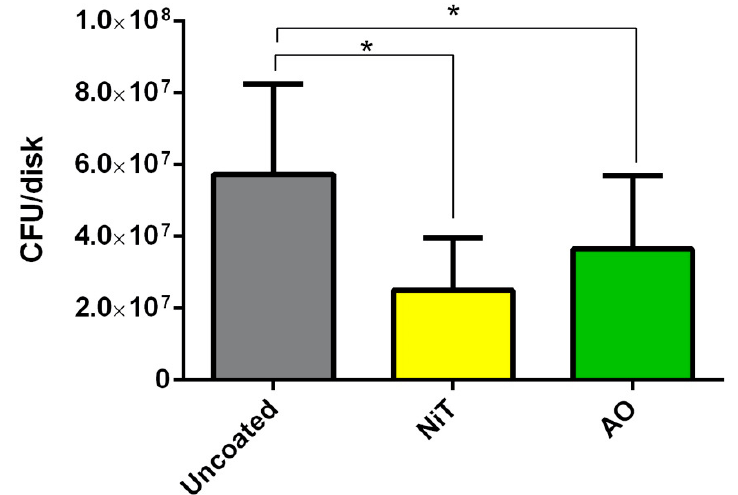
Figure 2. Streptococcus gordonii viable cells (expressed in CFU / disk) recovered from bacterial plaque formed on uncoated titanium, NiT, and AO. * p < 0.05.